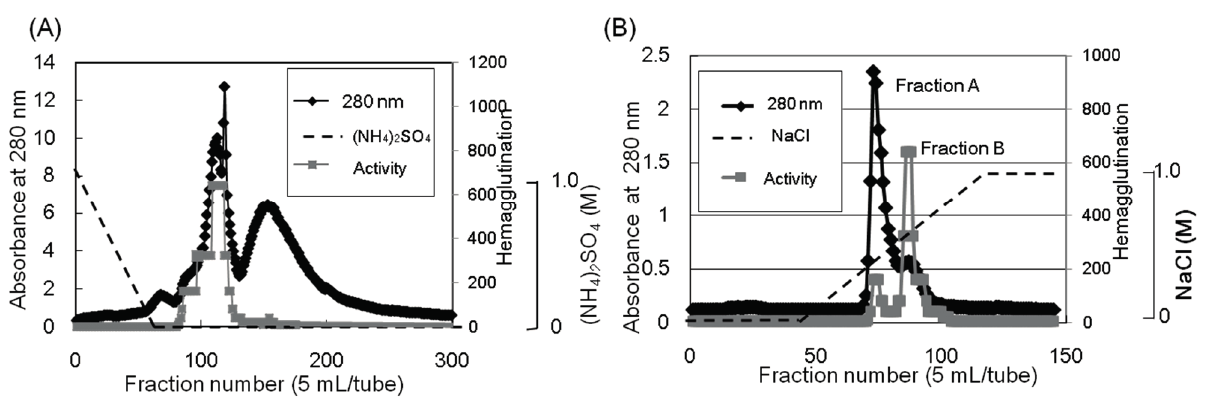
Figure 1. Purification of the Apios tuber lectin (ATL). ( A ) The protein fraction obtained by 40% saturated ammonium sulfate precipitation was separated by hydrophobic chromatography on a Toyopearl phenyl-650M column (2.8 × 16 cm) pre-equilibrated with 1.0 M ammonium sulfate in 50 mM Tris-HCl buffer (pH 8.0). Proteins were eluted with a decreasing linear gradient of ammonium sulfate (1.0–0 M) in the same buffer. Factions showing hemagglutination activity were collected and dialyzed against 50 mM Tris-HCl buffer (pH 8.0). ( B ) The dialysate was subjected to anion-exchange chromatography on a Toyopearl DEAE-650M column (2.8 × 32 cm) pre-equilibrated with 50 mM Tris-HCl (pH 8.0) and eluted with a linear gradient of NaCl (0 to 1.0 M) in the same buffer. Fractions A and B (ATL) were dialyzed against distilled water and